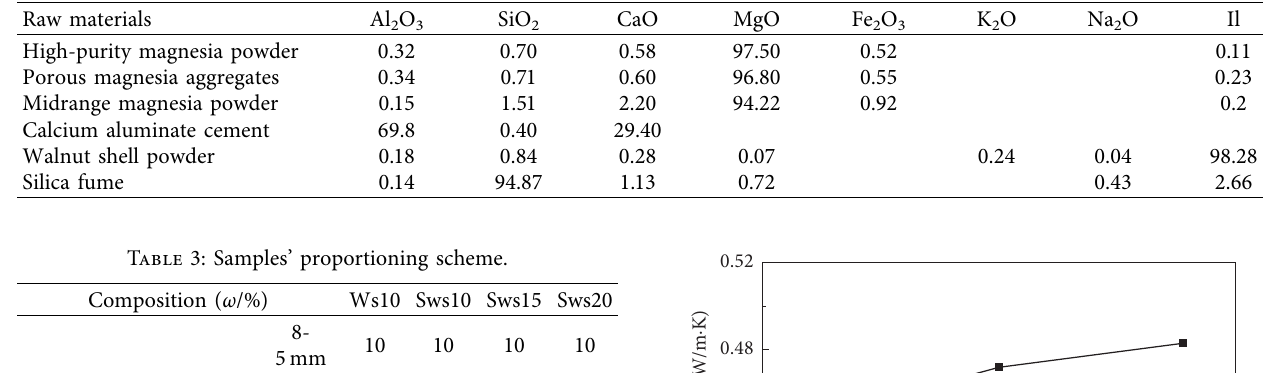
Table 2: Chemical compositions of the raw materials ( ω /%).